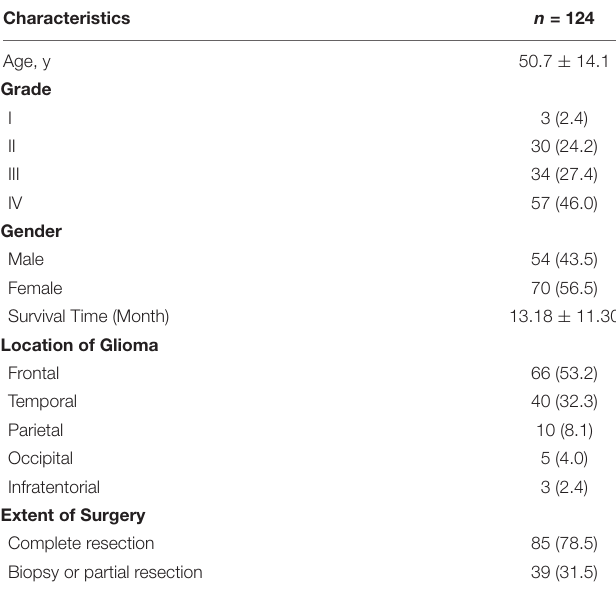
TABLE 1 | The Baseline Characteristics of Glioma